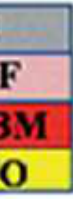
Figure 2. Electron-only device structure.